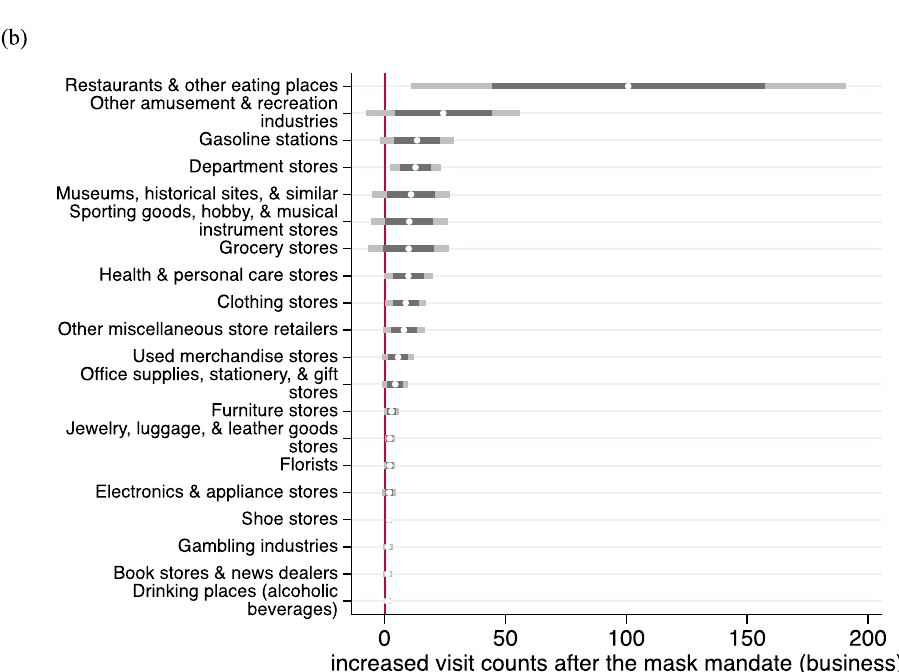
Figure 4. Estimates of increase in visits to a sample of specific types of locations following the face mask mandates ( a ) for public and ( b ) for business with 95% (dark gray) and 99.75% (grey) Bonferroni confidence intervals. A Bonferroni correction suggests that the 99.75% confidence interval is what should be used conservatively for a 5% probability of a type I error, to address concerns about multiple testing. Parks are included in Museums, historic sites, and similar institutions. Golf courses are included in Other amusement and recreation